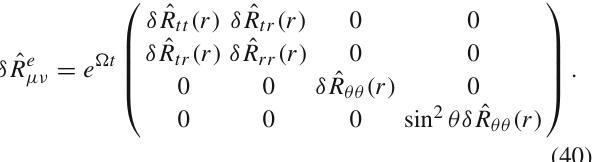
= O ( 1 )/ r | = r + = 1 , 2 , 4 0 2